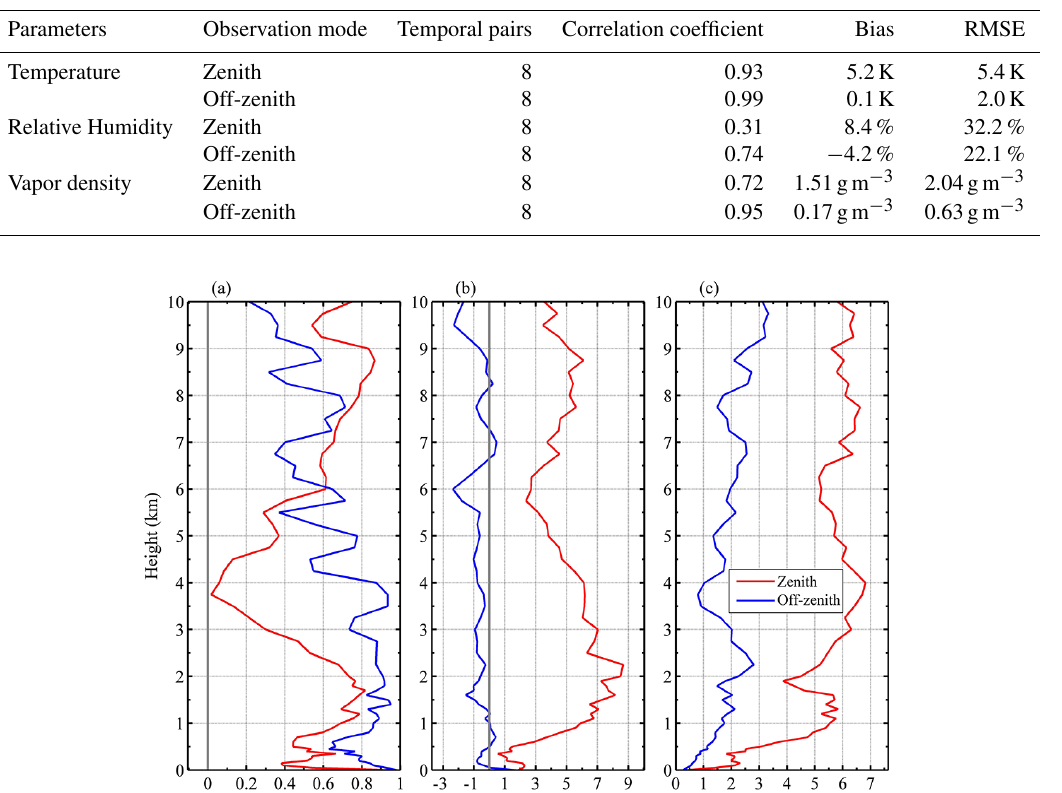
Figure 2. The correlation coefficient (a) , bias (b) , and RMSE (c) between the MWR and RAOB temperature in zenith (red) and off-zenith (blue)